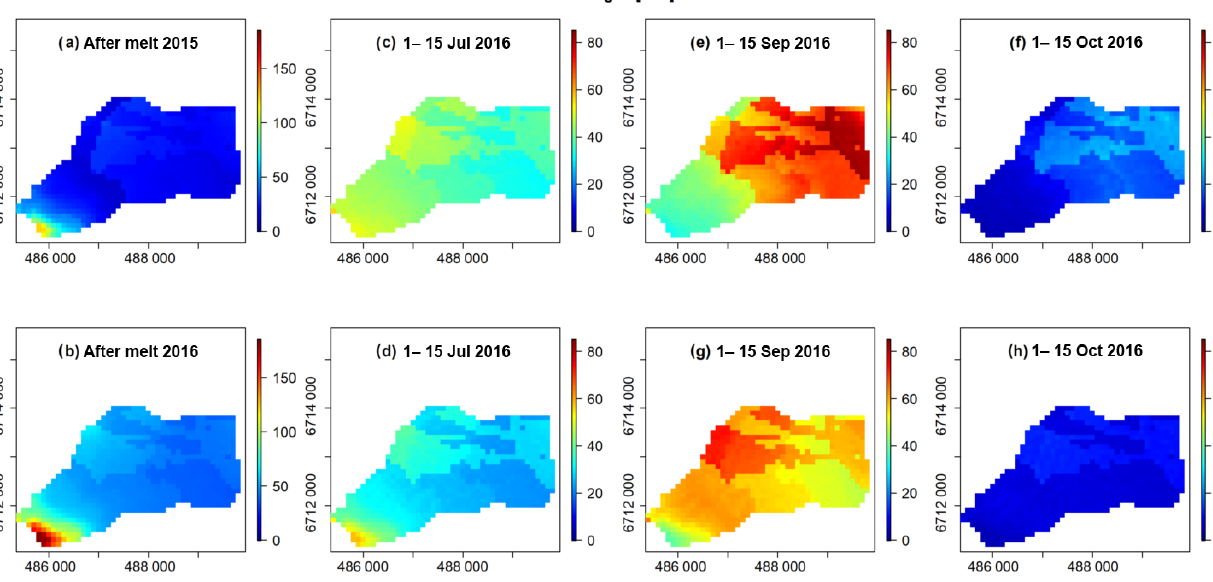
Figure 6. Spatial distribution of simulated water soil storages (mm). Daily snapshots on first snow-free day in the year: (a) 28 May 2015 and (b) 18 June 2016. Values averaged over 15d: (c) 1–15 July 2015, (d) 1–15 July 2016, (e) 1–15 September 2015, (f) 1–15 September 2016, (g) 1–15 October 2015 and (h) 1–15 October 2016. Note that scales in (a) and (b) are different to the scales in (c)